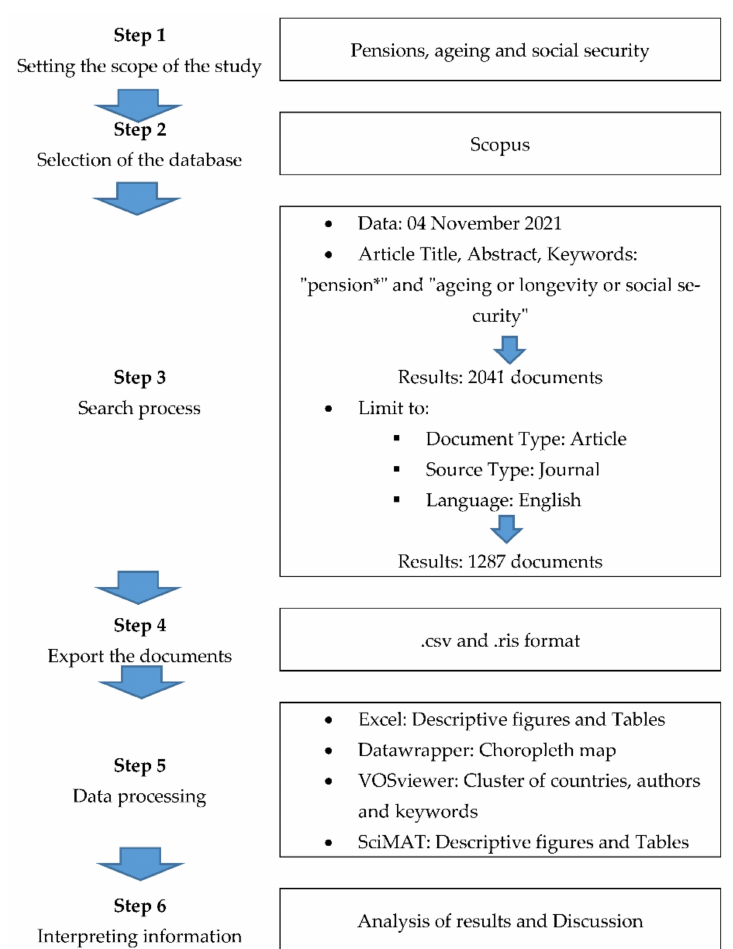
Figure 1. Flowchart